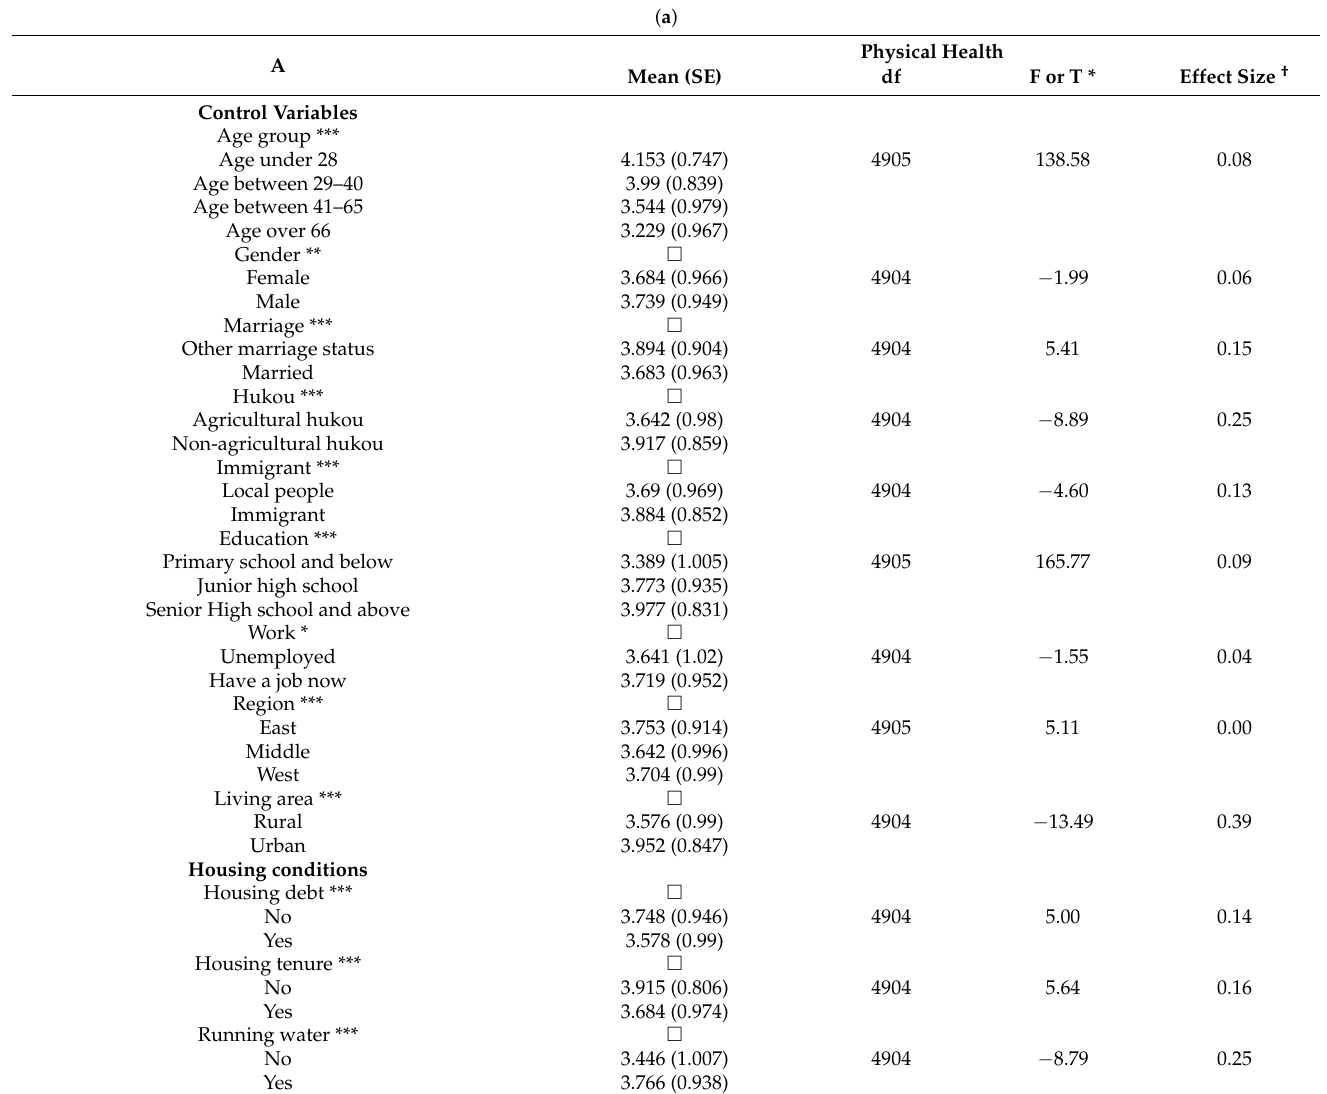
Table 2 shows the distribution of the physical health status (a) and mental health status (b) of the 4906 participants by each individual, housing, and neighborhood level. In terms of physical health score (see part a of Table 2), there is significant variance across most sociodemographic groups ( p < 0.05), socioeconomic groups ( p < 0.1), and housing conditions ( p < 0.01). In the neighborhood level context, significant differences were identified in the measures, except those relating to the availability of sports facilities and mutual help. In terms of mental health score (see part b of Table 2), there were no significant differences in the measures of age group and hukou. In the housing level context, we only observed mental health status variance in the housing debt ( p < 0.01) variable. In the neighborhood level context, measures of air pollution ( p < 0.1), water pollution ( p < 0.1), noise pollution ( p < 0.05), soil pollution ( p < 0.01), mutual familiarity ( p < 0.1), mutual help ( p < 0.01), neighborhood safety ( p < 0.01), and park facilities ( p < 0.01) exhibited significant variances in mental health status. Table 2. ( a ) Distribution of physical health status among 4906 participants in different sociodemo- graphic and socioeconomic groups, housing and neighborhood conditions. ( b ) Distribution of mental health status among 4906 participants in different sociodemographic and socioeconomic groups, housing, and neighborhood conditions. ( a